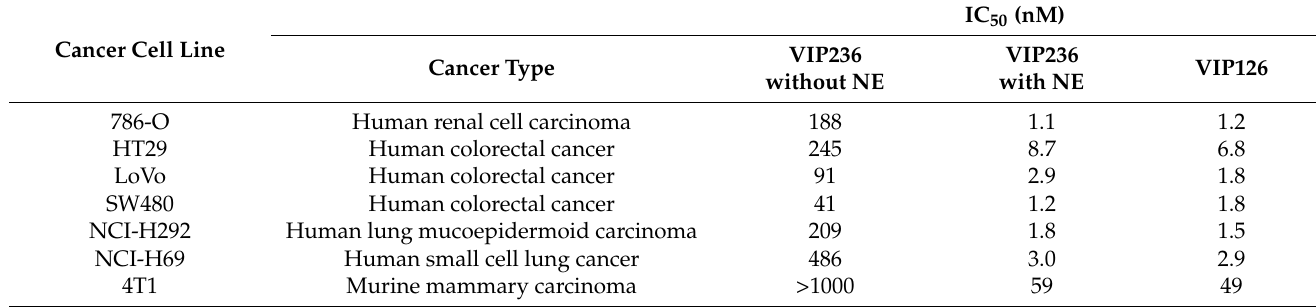
Table 3. Cytotoxic activity (IC 50 ) of VIP236 in the presence or absence of 10 nM NE in a panel of cancer cell lines. The values represent the mean value of at least two independent assays performed in triplicate ( n =